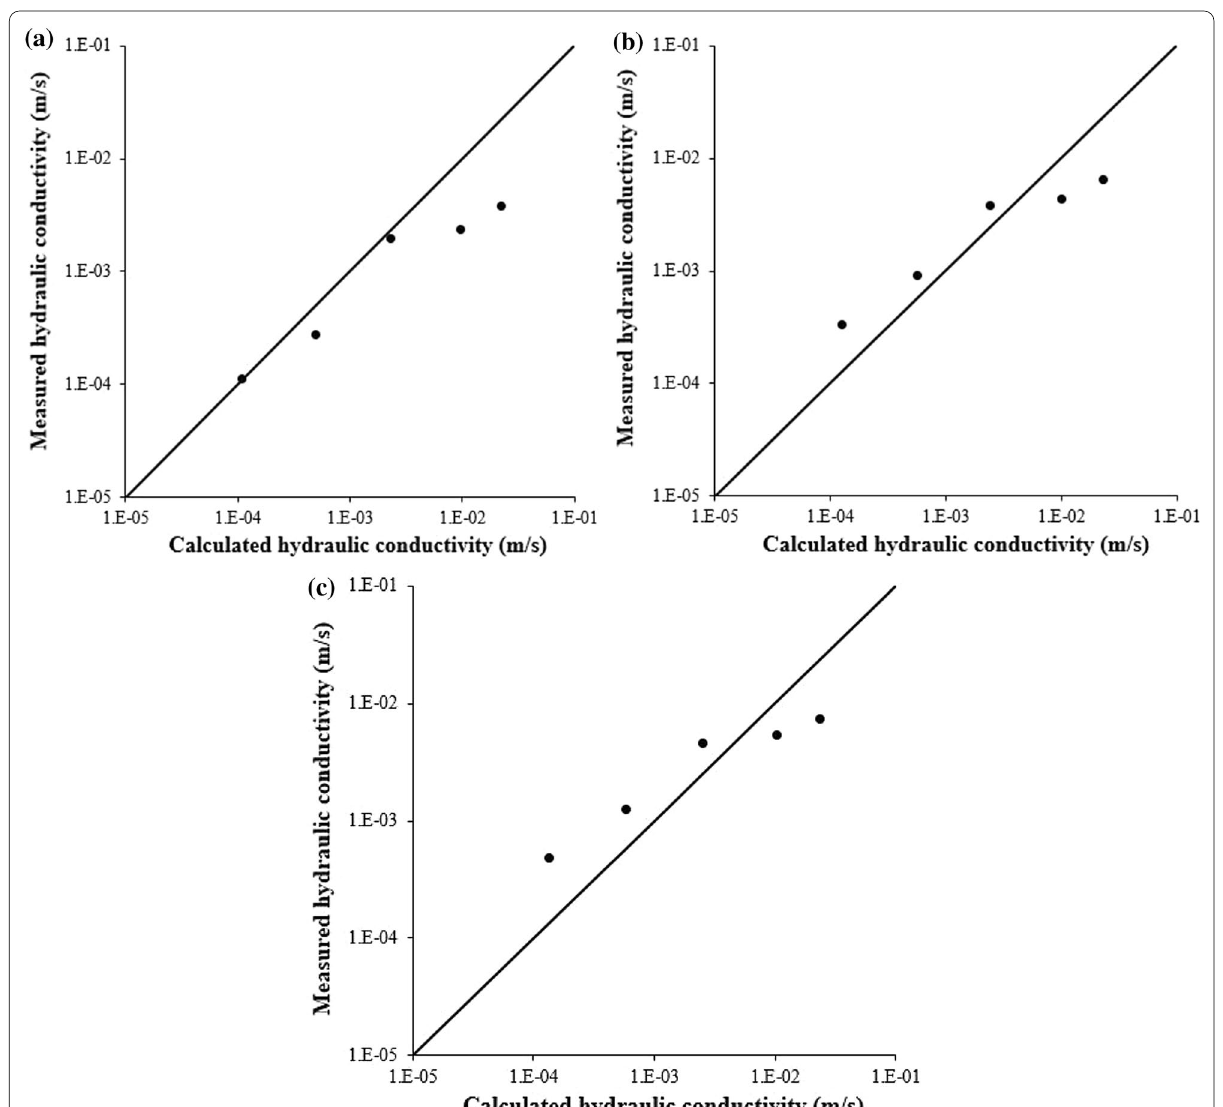
Fig. 7 Estimated hydraulic conductivity using modified Kozeny-Carman equation and measured hydraulic conductivity for a OD 600 2.25, b OD 600 0.75, and c OD 600